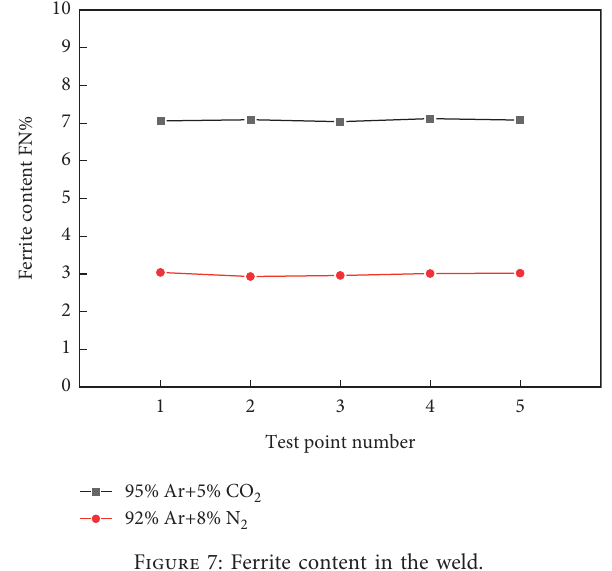
Figure 7: Ferrite content in the weld.